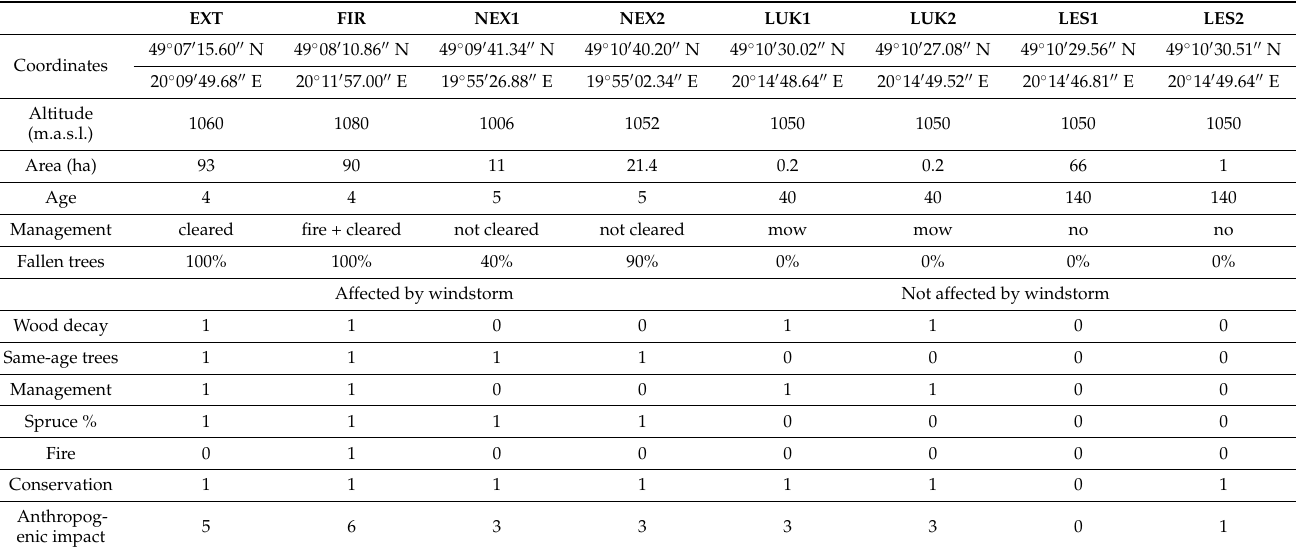
Table 1. Characterization of the study plots.